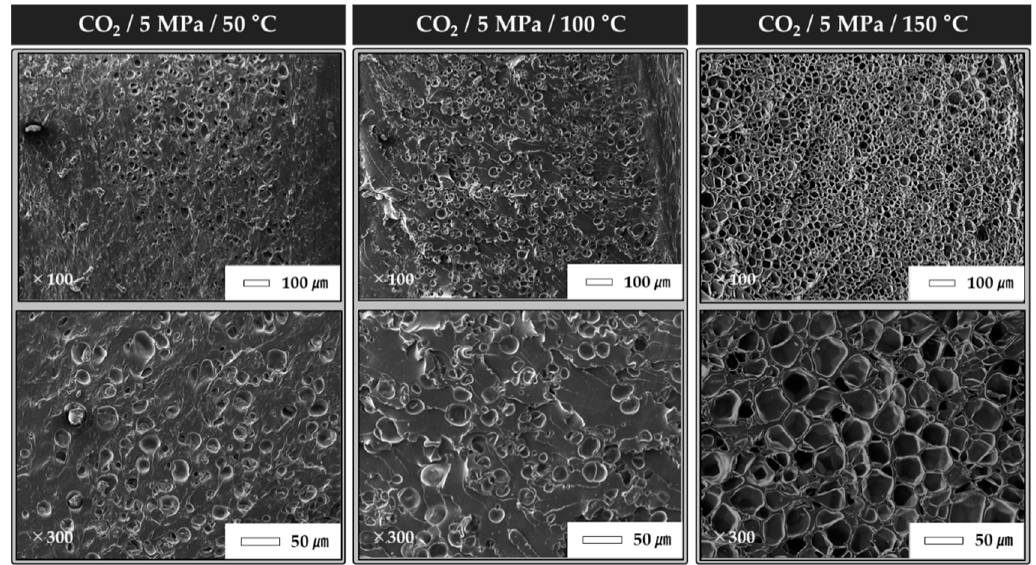
Figure 8. Cross-sectional SEM images of TPU specimens at different foaming temperatures.